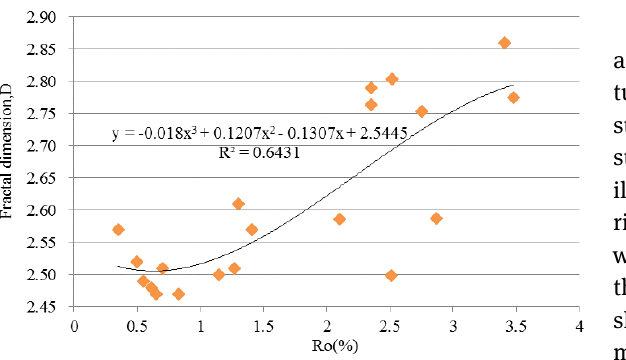
Figure 8: FHH pore fractal dimension with maturity of 0.35-1.41 (Chen et al.